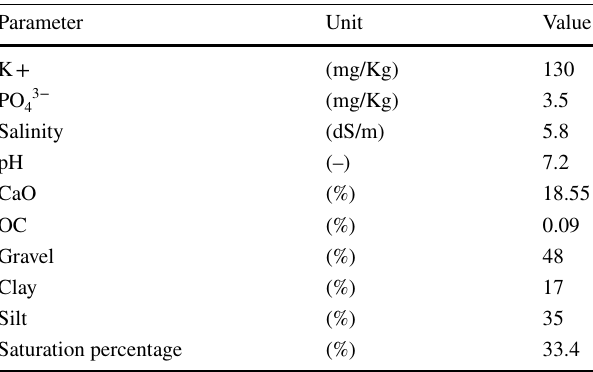
Table 2 Chemical and physical analysis at a depth of 0–40